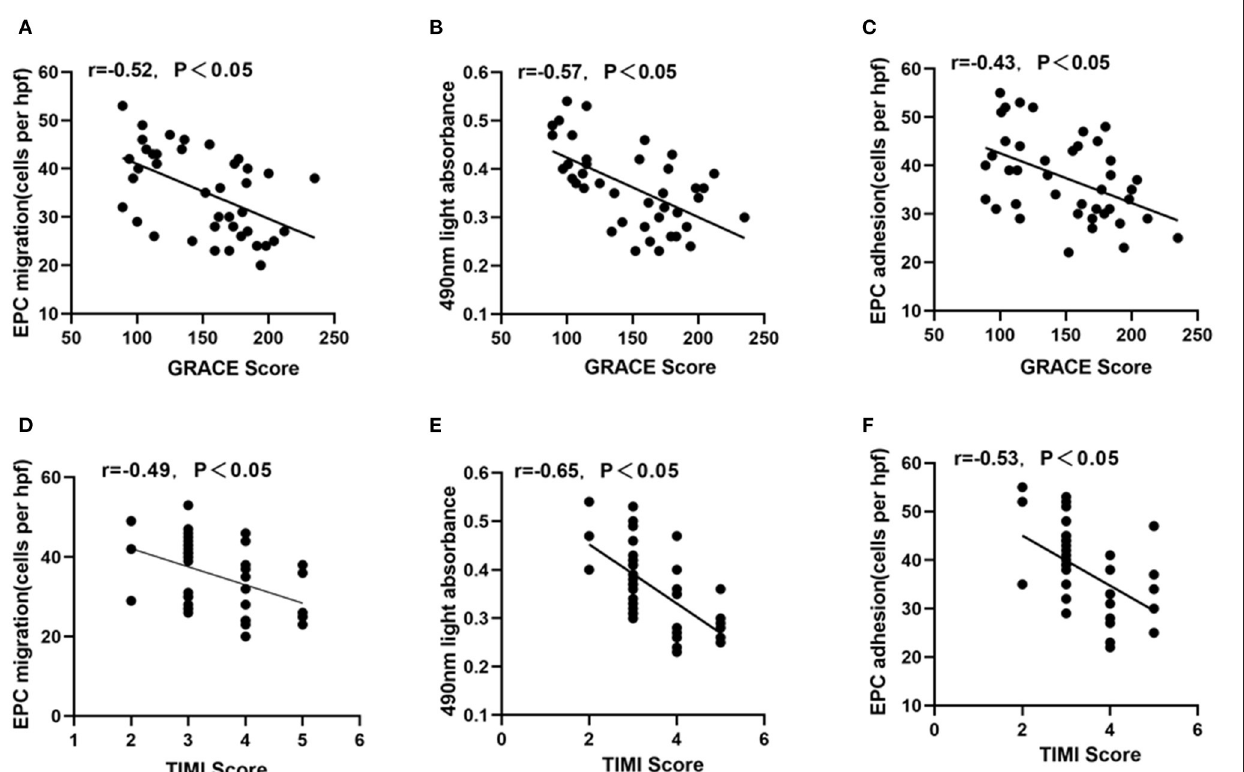
FIGURE 2 | Correlation between GRACE or TIMI score and EPC function. GRACE score was negatively correlated with EPC migration (A) , proliferation (B) , adhesion (C) . Similarly, TIMI score was also inversely related with EPC migration (D) , proliferation (E) , and adhesion (F) .